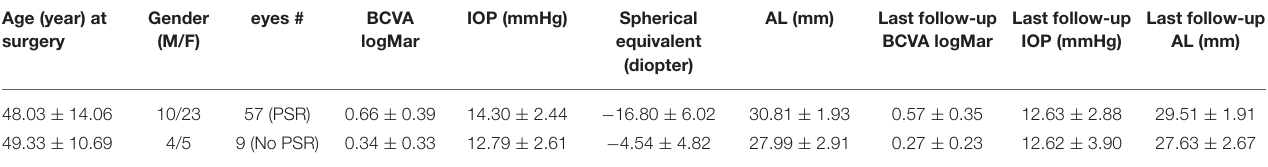
TABLE 2 | Key baseline and last follow-up parameters of the patients and eyes. Age (year) at Gender surgery